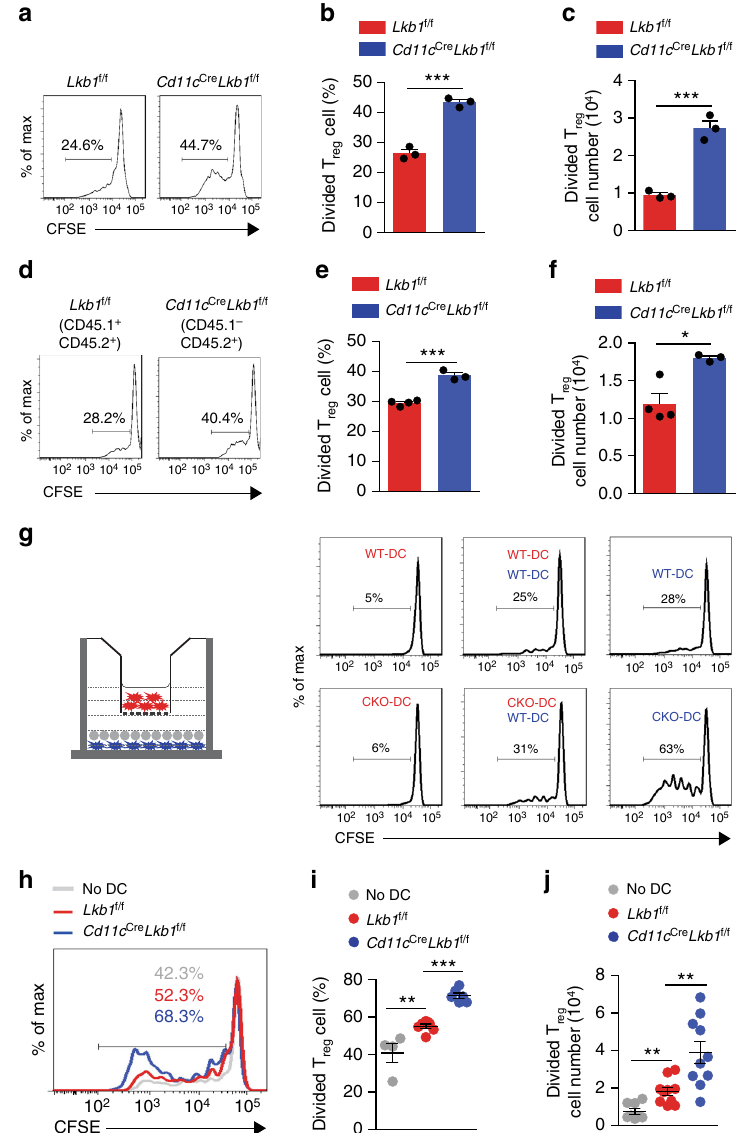
Fig. 3 Lkb1-de fi cient DCs directly stimulate T reg cell proliferation. a – c Flow cytometric analysis ( a ), percentage ( b ) and number ( c ) of CFSE-labelled T reg cells (CD4 + Foxp3 + , 2×10 5 ) sorted from B6 mice after co-culture with DCs (1×10 5 ) sorted from Lkb1 f/f or Cd11c Cre Lkb1 f/f mice supplemented with IL-2 for 4 days. d – f Flow cytometric analysis ( d ), percentage ( e ) and number ( f ) of CFSE-labelled T reg cells sorted from B6 mice after co-culture with WT or Lkb1- de fi cient DCs sorted from mixed BM chimaera mouse models. g Flow cytometric analysis of the proliferation of CFSE-labelled T reg cells sorted from B6 mice in the lower Transwell chamber after 4 days of co-culture with DCs from Lkb1 f/f (wild-type, WT) and/or Cd11c Cre Lkb1 f/f (conditional knockout, CKO) mice in the upper and/or lower chamber of a Transwell plate, in diverse combinations, as indicated. In the schematic diagram, grey dots indicate T reg cells, while red and blue dots indicate DCs in the upper and lower chamber, respectively. The coloured phrases in the histogram plots indicate the setup of DCs under each culture condition. h – j Flow cytometric analysis ( h ), percentage ( i ) and number ( j ) of CFSE-labelled T reg cells (CD4 + Foxp3 + , 2×10 6 ) sorted from B6 mice transferred together with or without DCs (1×10 6 ) sorted from Lkb1 f/f or Cd11c Cre Lkb1 f/f mice into irradiated NSG mice via tail vein injection for 3 days. The results are presented as the mean ± S.E.M., * P < 0.05, by Student's t -test ( b , c , e , f , i , j ). Data are pooled from b , c , i , j or are representative of a